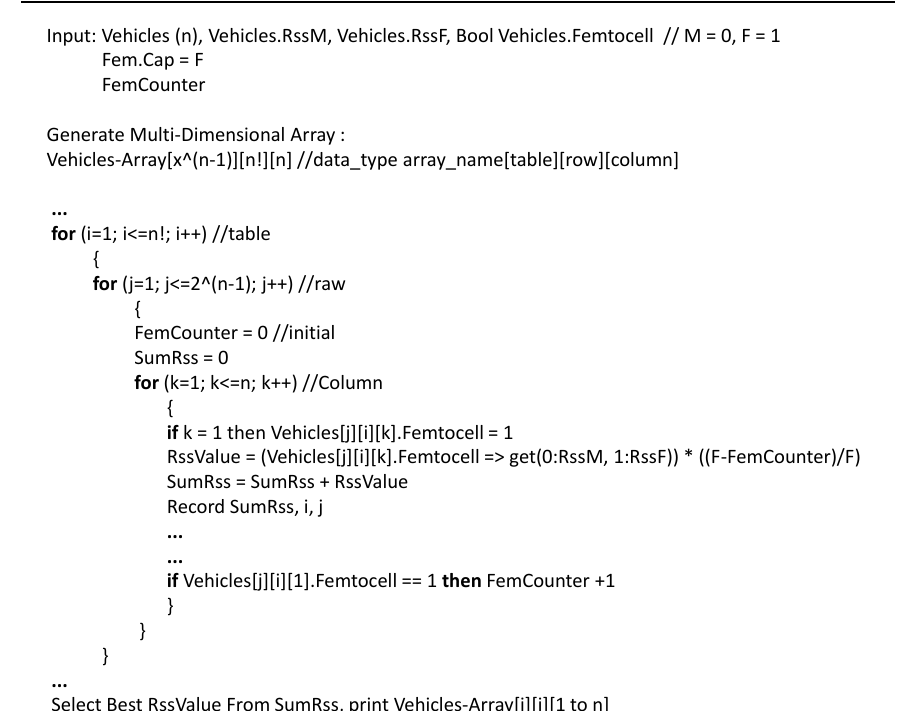
Algorithm 1 Markov Decision Policy